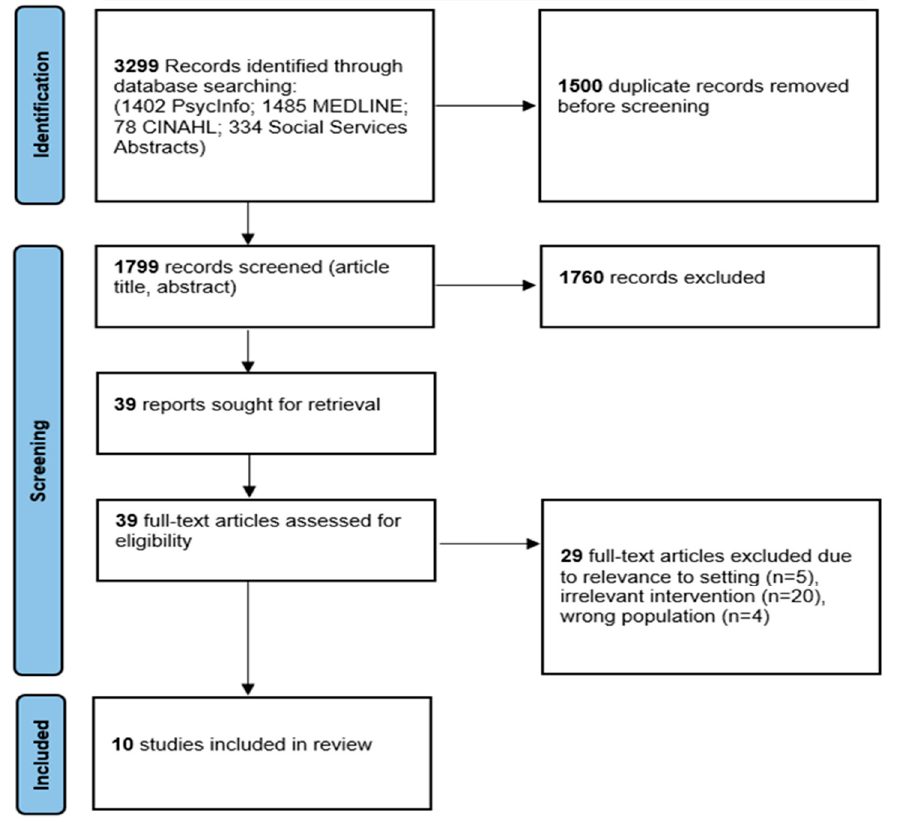
Figure 1. The Preferred Reporting Items for Systematic Reviews and Meta-Analyses (PRISMA) study flow diagram.